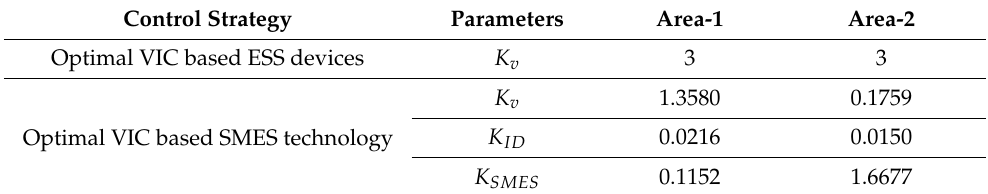
Table 6. The optimal parameters for VIC considering ESS devices and SMES technology. Control Strategy Parameters Area-1 Area-2 Optimal VIC based ESS devices K v 3 3 K Optimal VIC based SMES technology